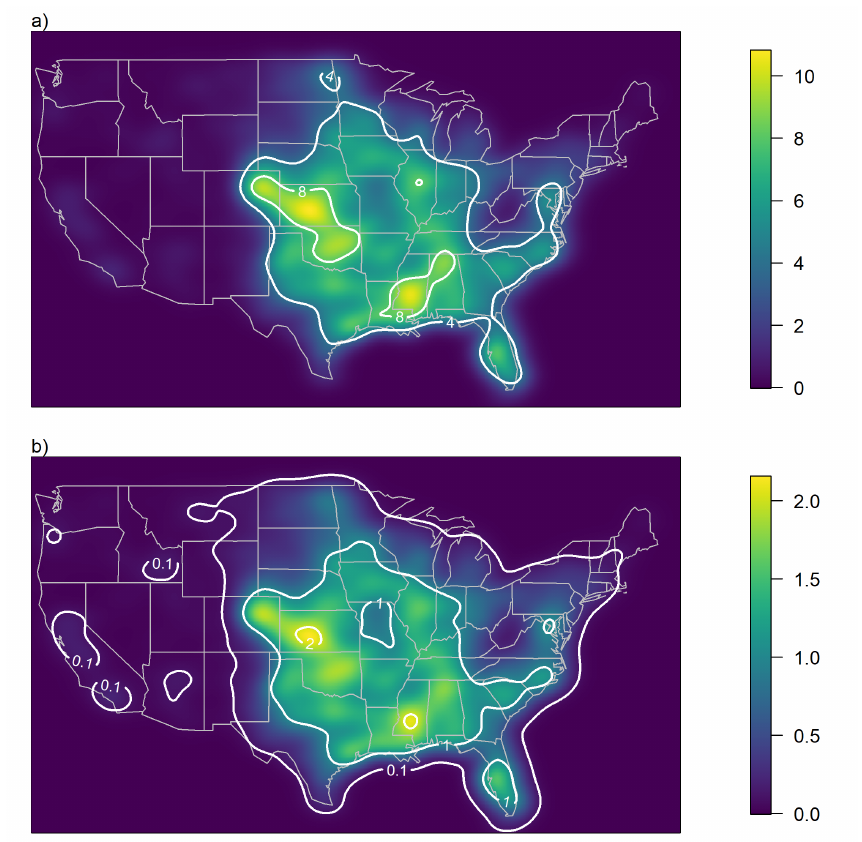
Figure 1. Tornado Climatology of the United States: ( a ) tornado occurrence rate per year and per 10,000 km 2 based on observations from 1991 to 2018, ( b ) local hit rate per 100,000 years with intensity of at least F3. While ( a ) answers the question how often tornadoes occur in a region, ( b ) answers the question how often on average a location in a region is hit with at least F3 intensity (for details see text). Contours of 4 and 8 tornadoes per year and 10,000 km 2 are drawn in map ( a ) and contours of 0.1, 1 and 2 hits per 100,000 years are drawn in map ( b ) as